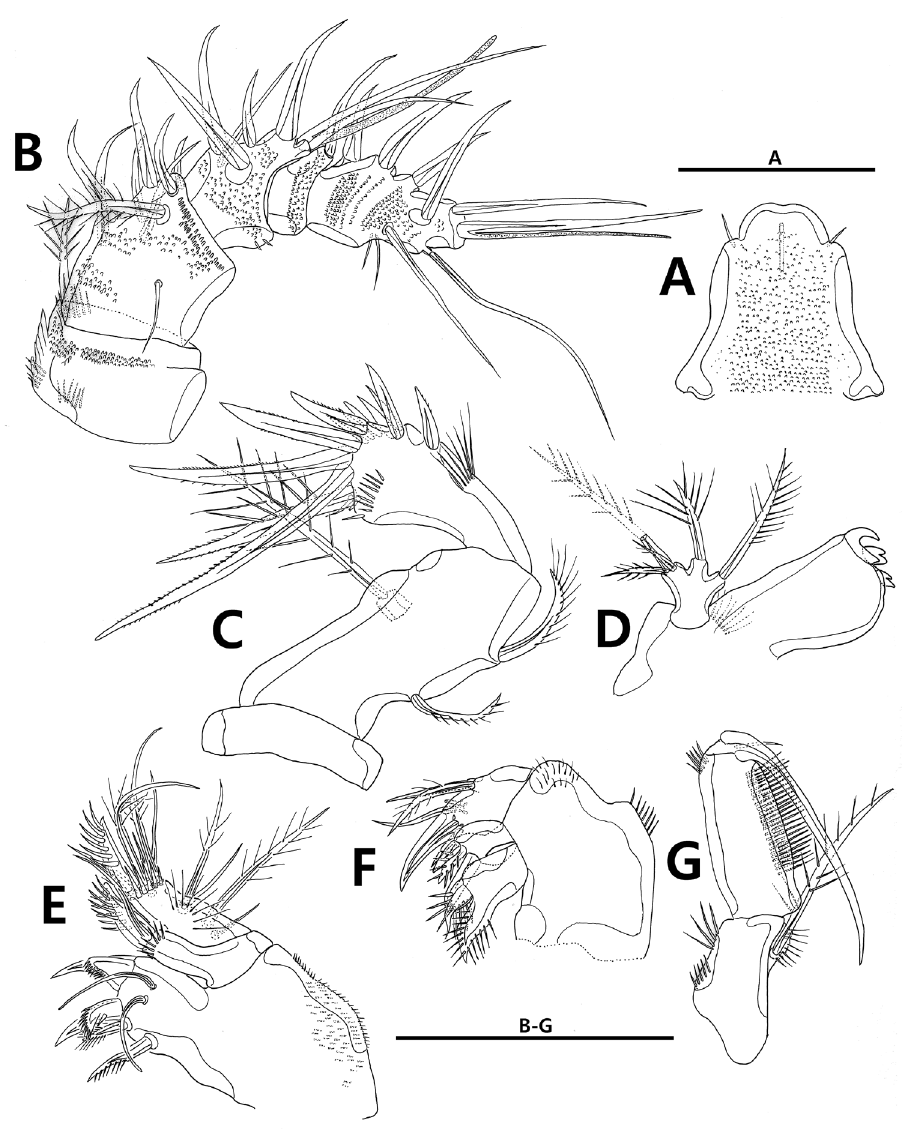
Figure 3. Strongylacron glabrum sp. n. female. A rostrum B antennule C antenna D mandible E maxillule F maxilla G maxilliped. Scale bars 50